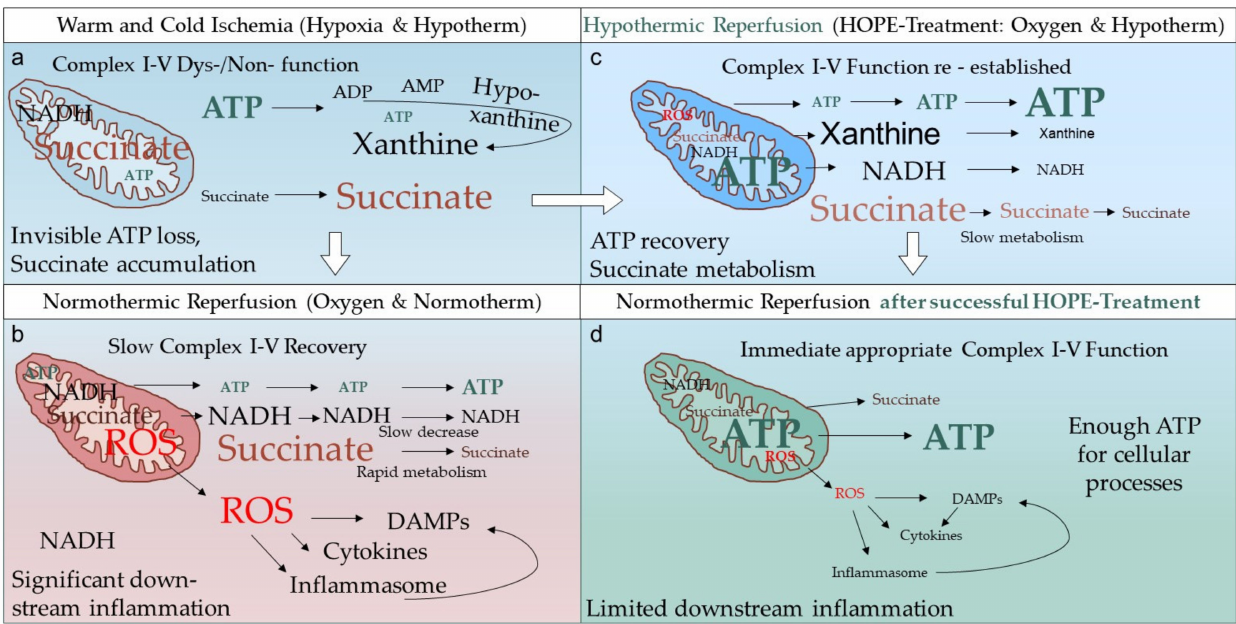
Figure 1. HOPE-Effect on mitochondria. During warm and cold ischemia, the tricarboxylic acid cycle (TCA) and the electron transfer is on hold with a subsequent succinate accumulation. Another direct consequence is the loss of ATP, which is broken down to the precursors, hypoxanthine and xanthine [5]. The dysfunctional cellular respiration also leads to a high number of NADH molecules, stuck at Complex-1 ( a ). When such tissues undergo direct normothermic reoxygenation (reperfusion), mitochondria aim to decrease the high load of succinate with the quick reestablishment of the electron flow. This, however, leads to an immediate release of reactive oxygen species (ROS) mainly from Complex-1. Such ROS molecules leak through the mitochondrial membrane and further damage other cell components, with additional release of danger associated molecular patterns (damps) and cytokines. The result of this IRI cascade is an ubiquitarian inflammation, which depends directly on the initial organ quality. Similarly, the time needed to recover cellular ATP and metabolize succinate and NADH after normothermic reperfusion or transplantation is linked to the number of healthy mitochondria able to quickly recover from the IRI ( b ). In contrast, during hypothermic oxygenated perfusion (HOPE, D-HOPE, HMP-O 2 ) the aerobe respiration is reestablished with a normally directed electron flow, very limited ROS release from Complex-1 and full ATP recovery ( c ). Paralleled by a slow succinate and NADH metabolism, such cold pre-treatment of solid organs provides enough cellular energy (ATP) and prevents later ROS release at rewarming and reperfusion under normothermic conditions ( d